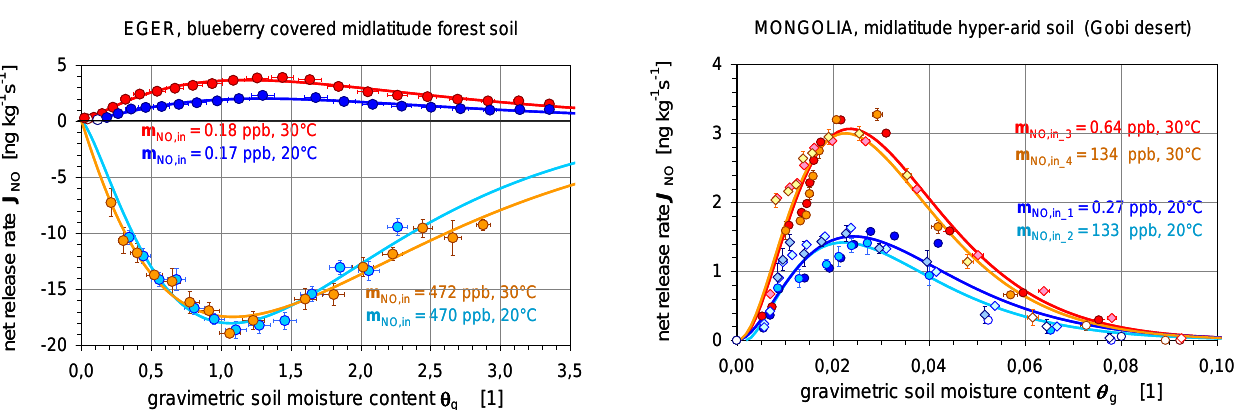
Figure 13. As Fig. 10, but for a sample taken from an organic-rich forest soil covered with blueberries (Fichtel Mountains, SE Ger- Fig. 13: as Fig. 10, but for a sample taken from an organic rich forest soil covered with blueberries (“Fichtelgebirge”, SE Germany). Data points marked by empty circ- many). Data points marked by empty circles fall within the “dead- les fall within the “deadband” of non-detectable J NO -values (defined by band” of non-detectable J NO values (defined by ± minimum de- ± minimum detectable net NO release rate; s. Section 4.3). tectable net NO release rate; see Sect. 4.3).